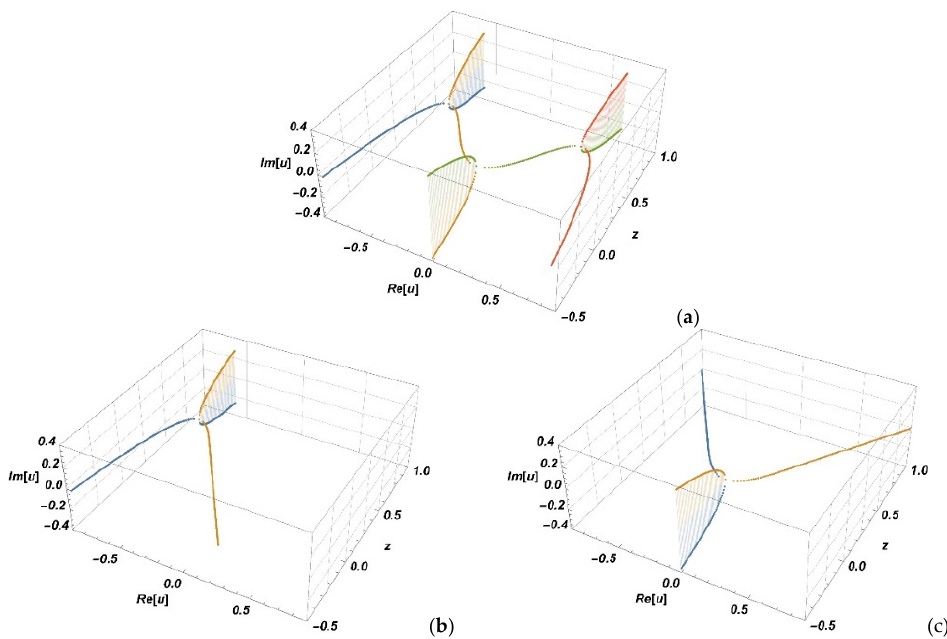
(1) ( 1,0, ; ) f z u − 1 ( − 1,0, z ; u ) ( b ), and 1